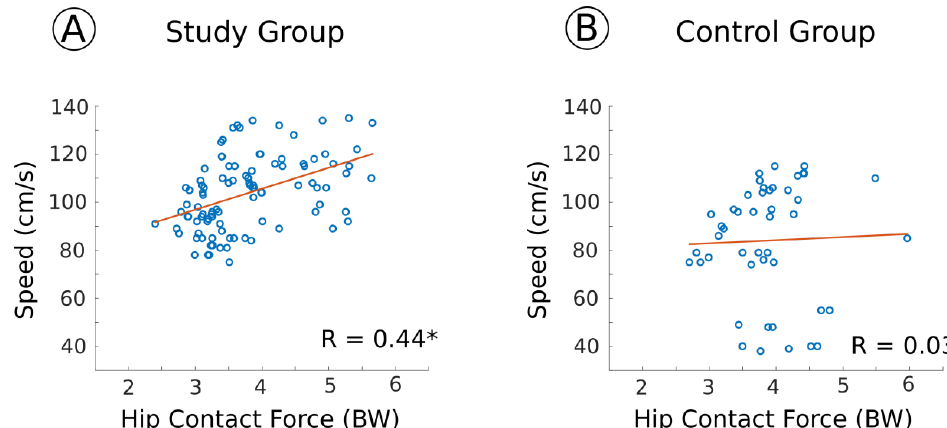
Figure 3. Linear correlations between gait speed and hip contact force peaks in all walking trials, for the Study Group ( A ) and Control Group ( B ). Correlation coefficients (R) are reported and indicated with an asterisk (*) when statistically significant ( p <